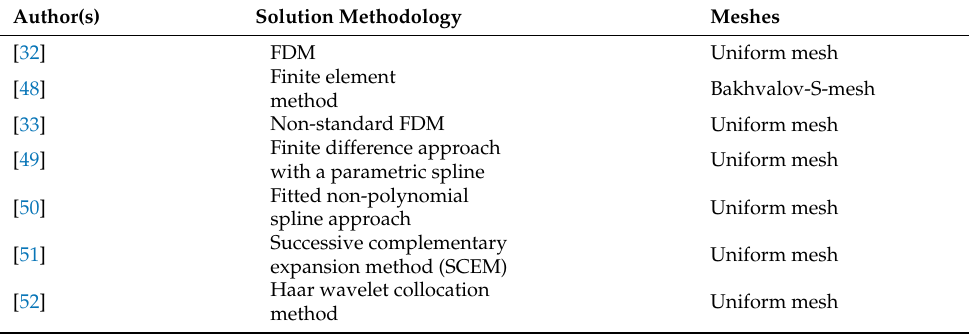
Table 3. Various methods and mesh used to solve Equations (1) and (2).